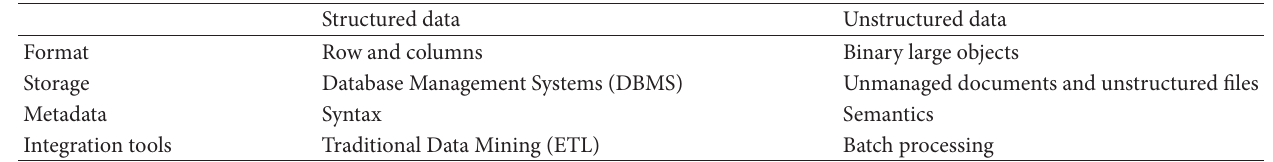
Table 5: Structured versus unstructured